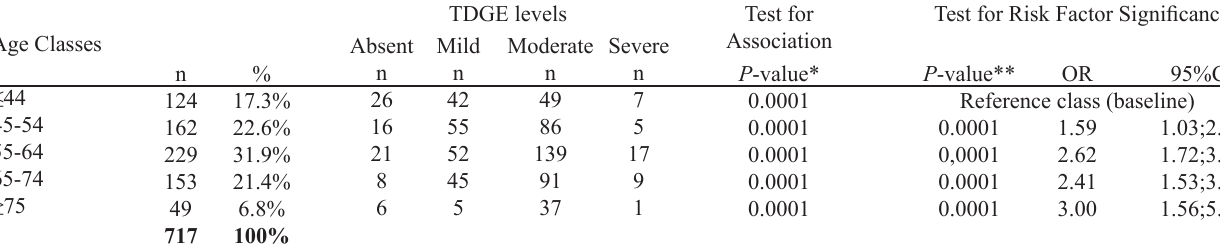
Table 4. Association of age with TDGE